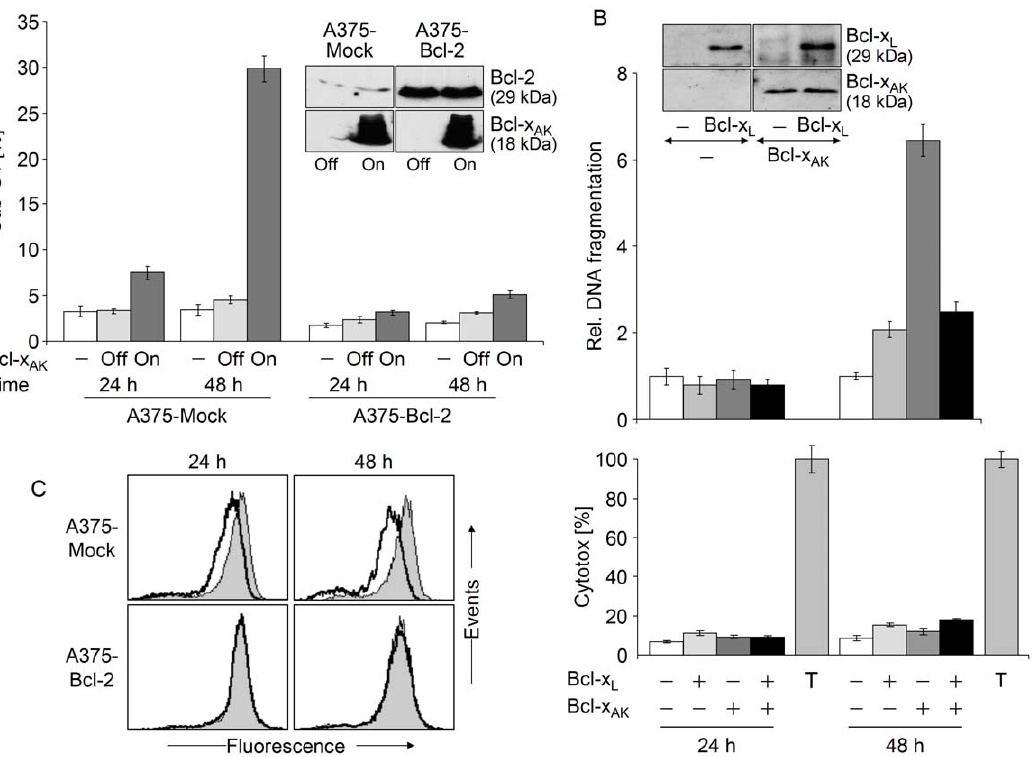
Figure 5. Bcl-2 and Bcl-x L block the proapoptotic effects of Bcl-x AK . (A) Subclones of A-375 cells stably transfected with pIRES-Bcl-2 (A375- Bcl-2) or mock-transfected (A375-Mock) were transduced with AdV-AK under OFF or ON conditions. Non-transduced cells ( 2 ) were used as additional controls. Numbers of apoptotic cells (sub-G1 cell populations) were determined by flow cytometry after PI staining. (B) SK-Mel-13 melanoma cells were transiently transfected with either Bcl-x L or Bcl-x AK alone or with a combination of both (each 2.5 m g plasmid-DNA). Relative DNA fragmentation values, as determined at 24 h and 48 h after transfection, were calculated with respect to cells that had received only the transfection lipid (white bars). (A, B) Means and SDs of triplicate values of a representative experiment are shown (each two independent experiments). Overexpression of Bcl- 2, Bcl-x L and Bcl-x AK , as determined by Western blot analyses, is shown in the insets. (C) The mitochondrial membrane potential ( Dy m ) was determined by flow cytometry after TMRM staining in A375-Mock and in A375-Bcl-2 at 24 h and 48 h. After transduction with AdV-AK, inducible and non inducible conditions were compared (On/Off). The experiment was performed three times, giving comparable results.